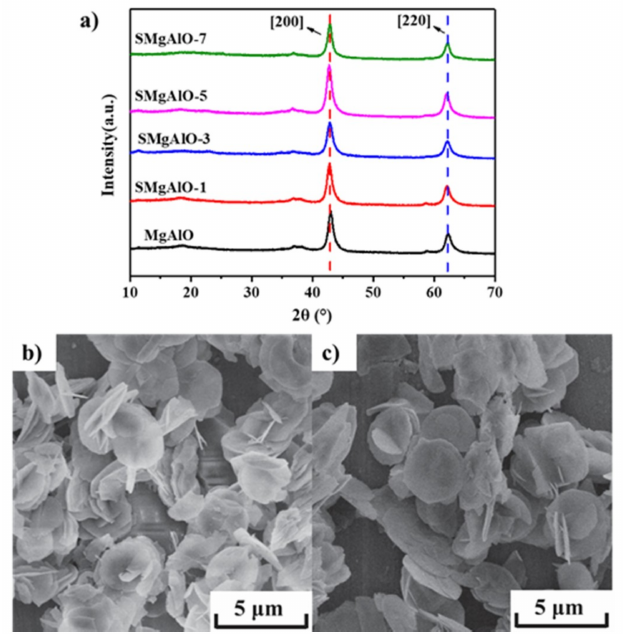
Figure 1. Crystal and morphologic structure of MgAlO and SMgAlO-y:XRD patterns ( a ); and SEM images of MgAlO ( b ), and SMgAlO-5 ( c ).